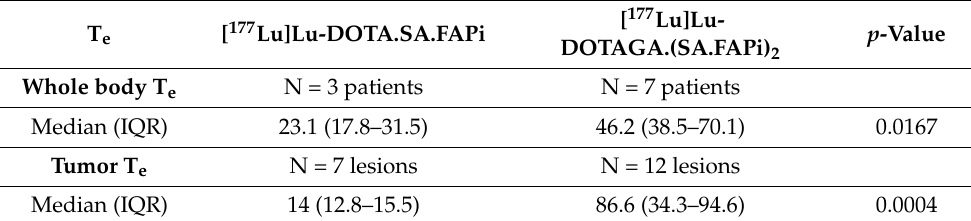
Table 7. Comparison of T e between [ 177 Lu]Lu-DOTA.SA.FAPi and [ 177 Lu]Lu-DOTAGA.(SA.FAPi) 2 post-therapy